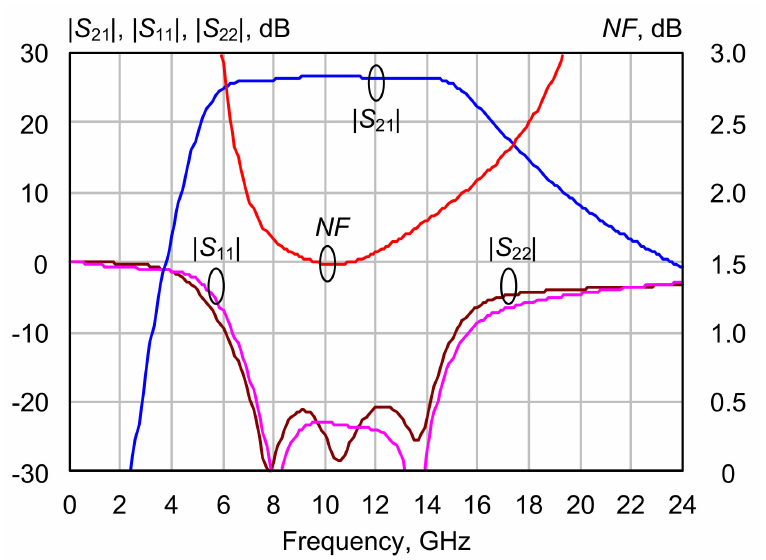
Figure 12. Simulated S-parameters of the three-stage LNA developed using the first release of